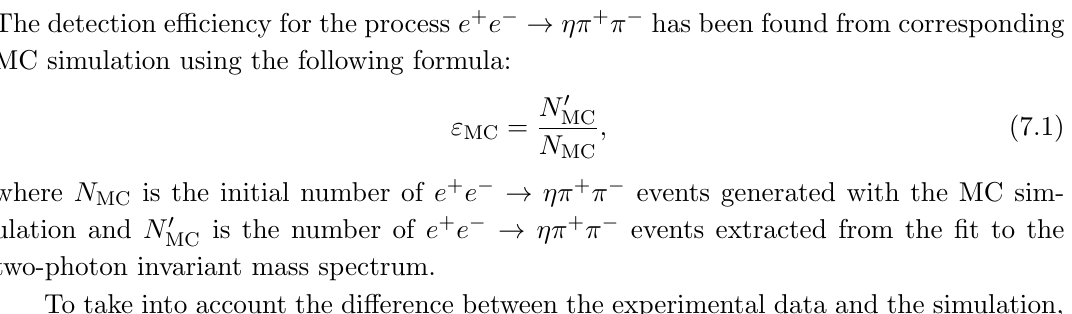
Figure 4 . (cid:25) + (cid:25) (cid:0) invariant mass spectra for the experimental data (points with error bars) and simulated e + e (cid:0) ! (cid:17)(cid:25) + (cid:25) (cid:0) events (histogram) from the energy range simulation uses a model of the (cid:17)(cid:26) (770) intermediate